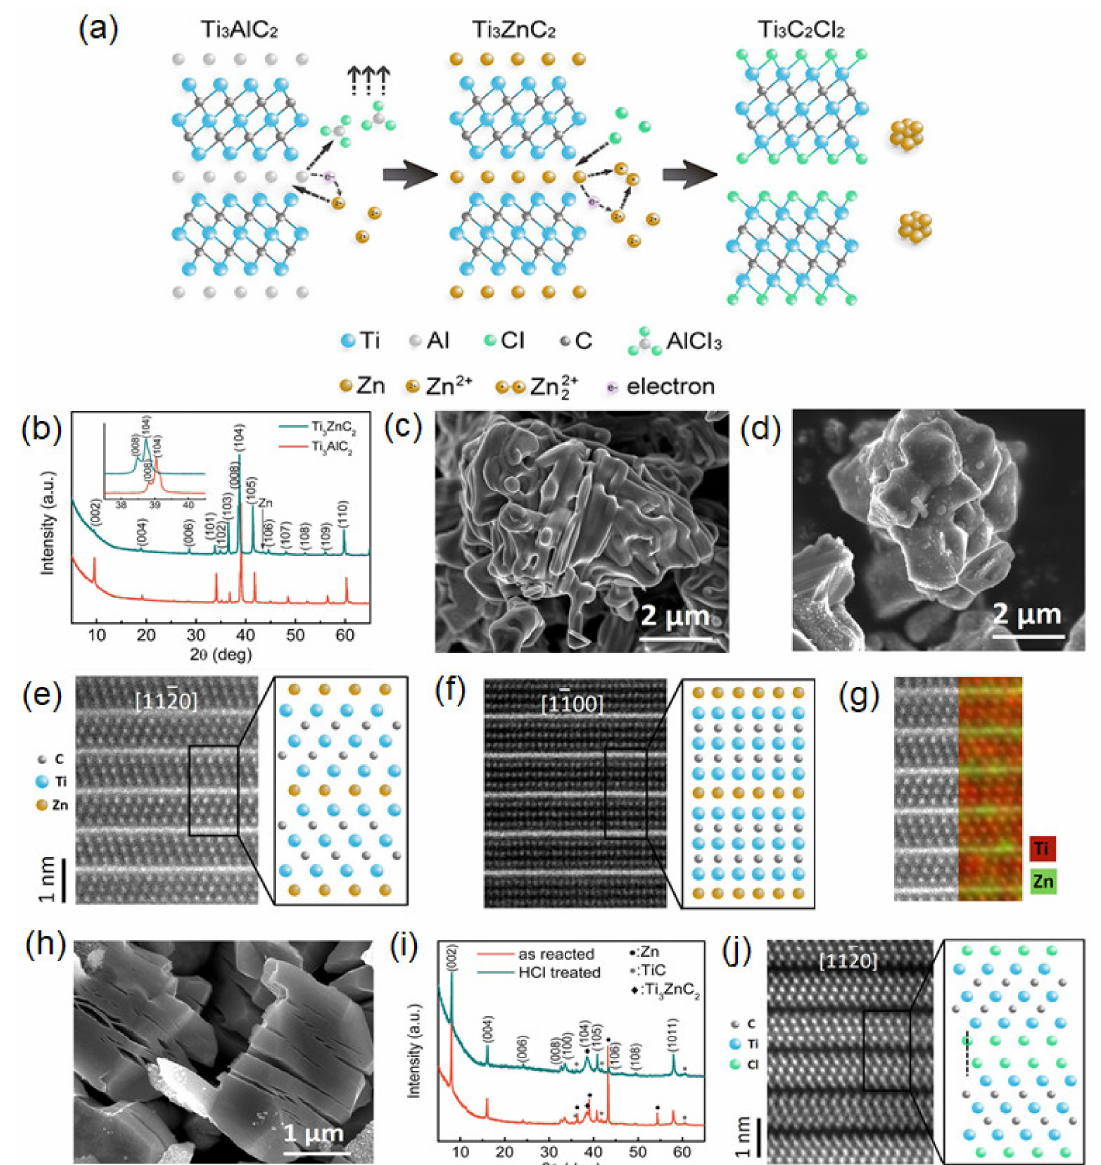
Figure 2. ( a ) Schematic illustration of the preparation of Ti 3 ZnC 2 and Ti 3 C 2 Cl 2 . ( b ) XRD patterns of Ti 3 AlC 2 and Ti 3 ZnC 2 . ( c ) SEM image of Ti 3 AlC 2 . ( d ) SEM image of Ti 3 ZnC 2 . ( e , f ) HR-STEM image of Ti 3 ZnC 2 . ( g ) HR-STEM and the correspond- ing EDS map of Ti 3 ZnC 2 . ( h ) XRD patterns from the as-reacted product and HCl-treated product. ( i ) SEM image Ti 3 C 2 Cl 2 in the as-reacted sample. ( j ) HR-STEM image of Ti 3 C 2 Cl 2 . Reprinted (adapted) from Reference [50], copyright (2019) American Chemical